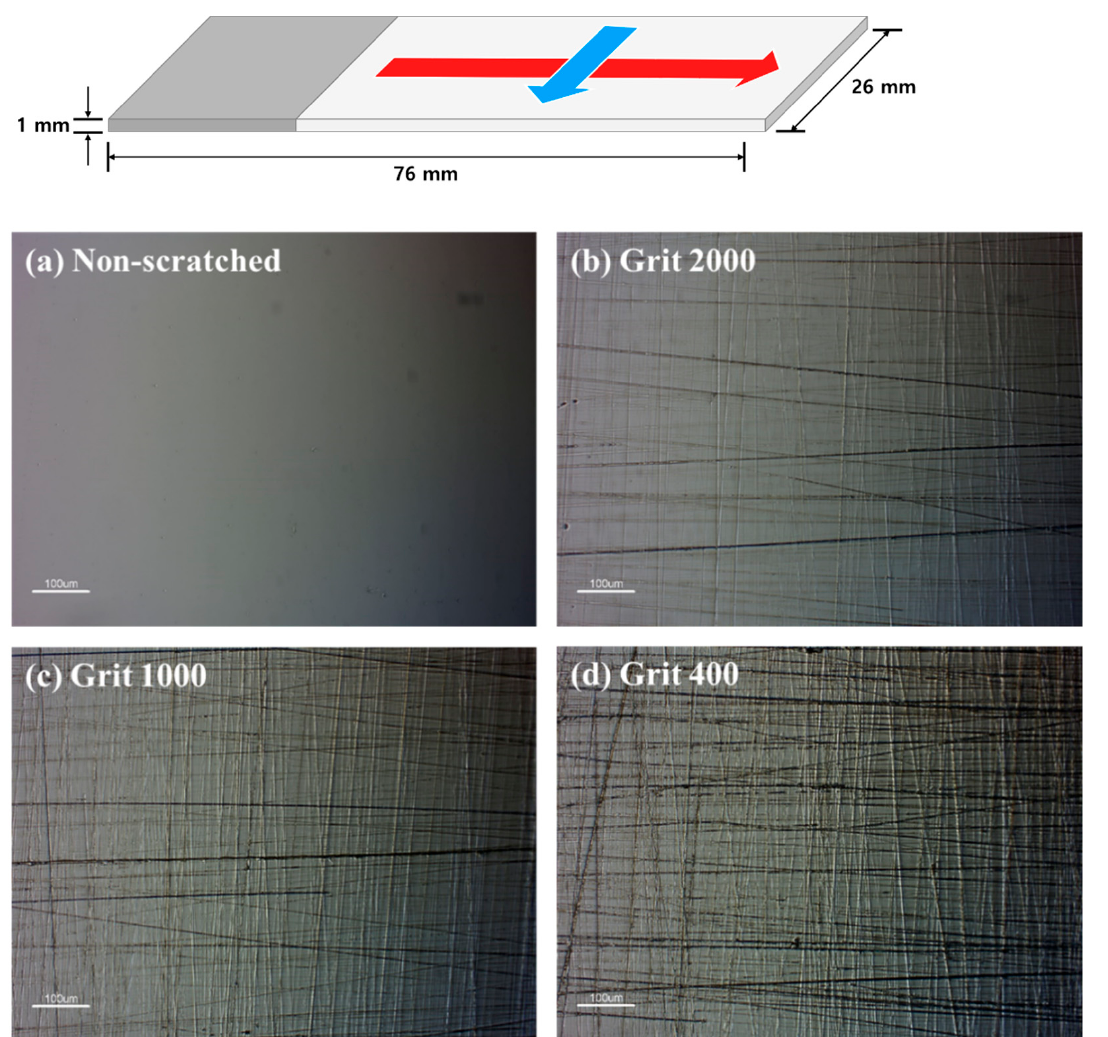
Figure 2. Schematic diagram of scratching the microscope slide glass sample by sandpaper ( upper ) and their Stereo Microscope images ( lower ) ( a ) Non-scratched ( b ) Grit 2000 ( c ) Grit 1000 ( d ) Grit 400.